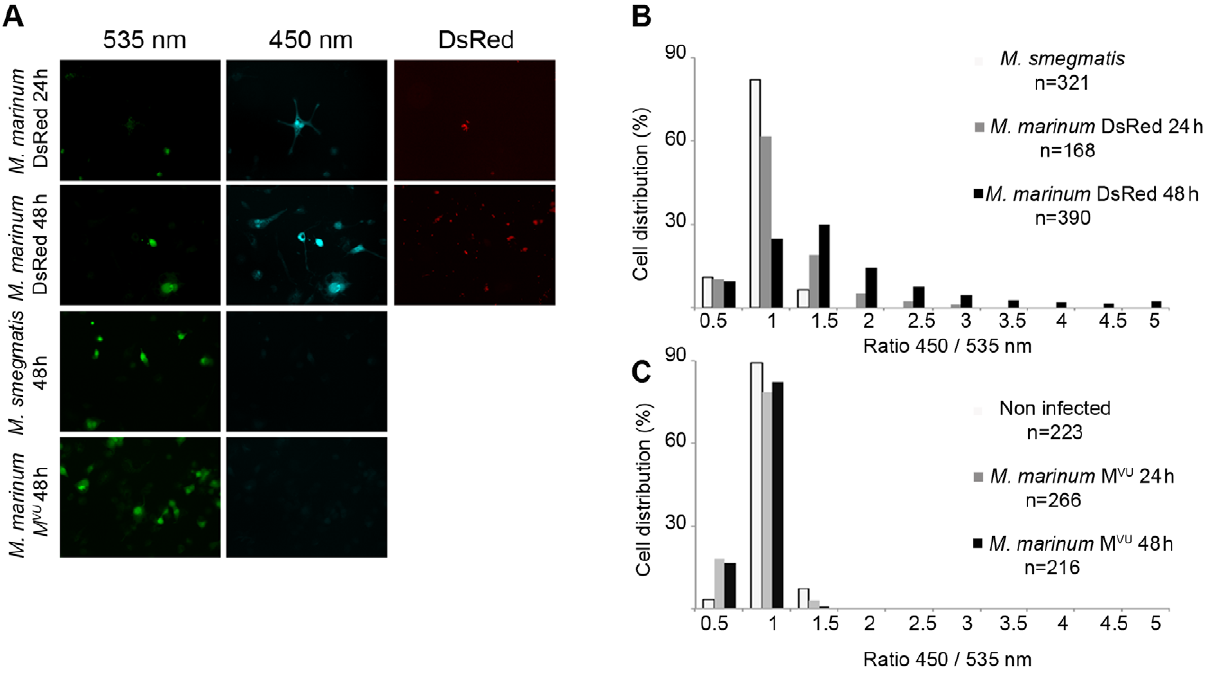
Figure 1. M.marinum is able to rupture the phagosome of THP-1 cells unlike an ESAT-6/CFP-10 secretion-deficient strain. THP-1 cells were infected with M. marinum expressing DsRed, M. smegmatis or M. marinum M VU at a MOI of 1 for the indicated time and then loaded with CCF-4 molecule for 2 h. After PFA fixation, cells were imaged by fluorescence widefield microscope Nikon Ti with 20X objective (A). Picture acquisition was done randomly and automatically for each condition on 36 fields to follow the FRET signals and the fluorescent bacteria. Data represented in panels B and C were obtained via specialized algorithms using the Metamorph software. The plots are representative of 3 independent experiments.